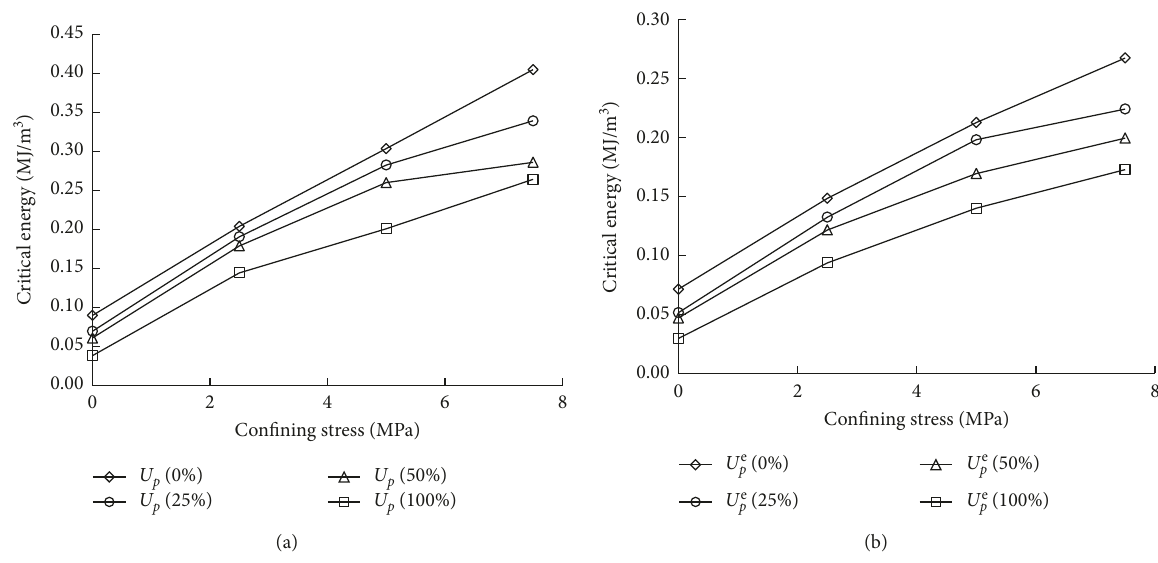
Figure 6: Critical energy curves under different confining pressures: (a) U